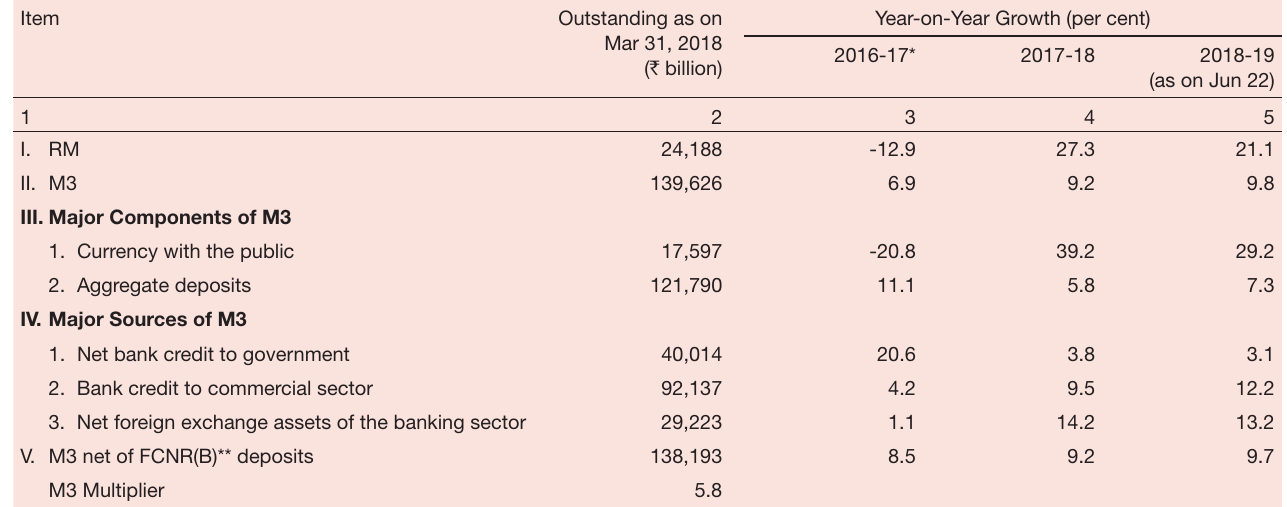
Table II.3.1: monetary